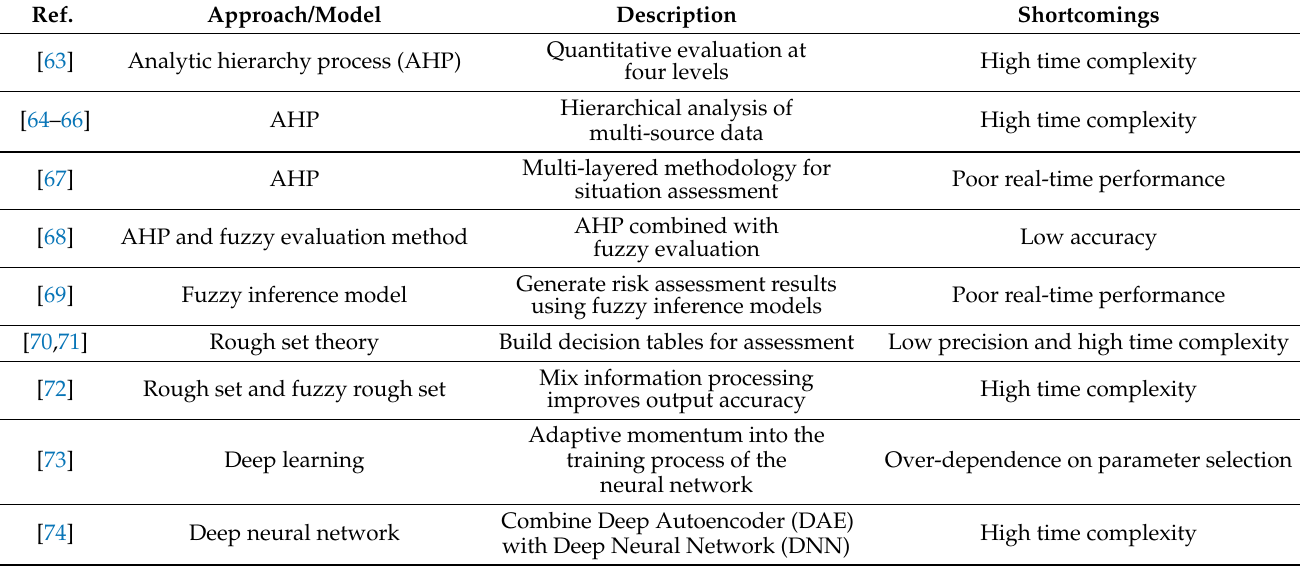
Table 3. Researchers on the network security situation assessment of relevant work.